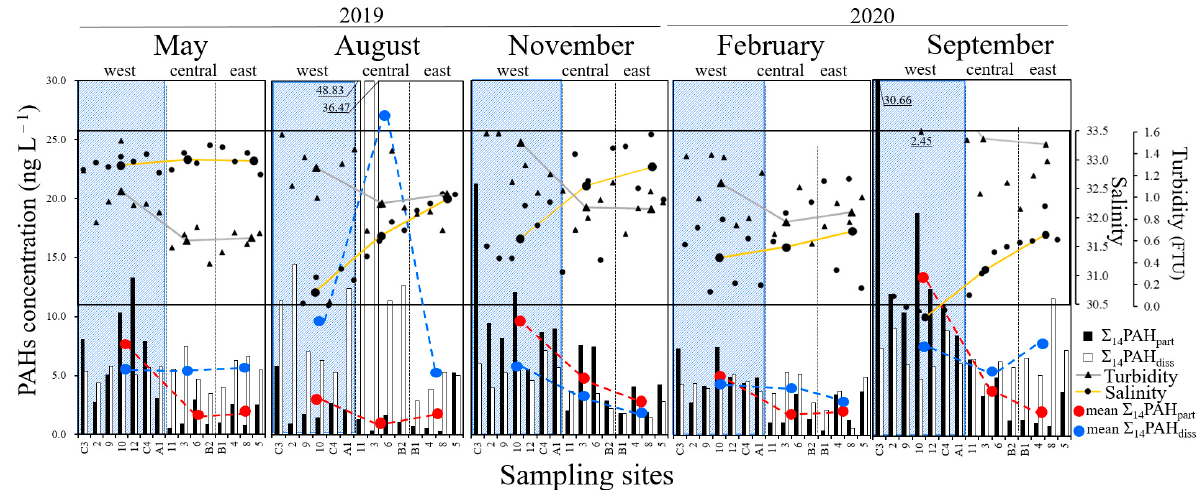
Figure 2. Variations in particulate ( Σ 14 PAH part , black) and dissolved ( Σ 14 PAH diss , white) PAHs in West Nanao Bay, Japan; May 2019–September 2020 and respective effluent rivers. Mean Σ 14 PAH part and Σ 14 PAH diss by area is marked in red and blue, mean turbidity (FTU) and salinity by area is marked in gray and yellow, respectively. Turbidity and salinity of each sampling point are marked by white triangles and white circles, respectively.